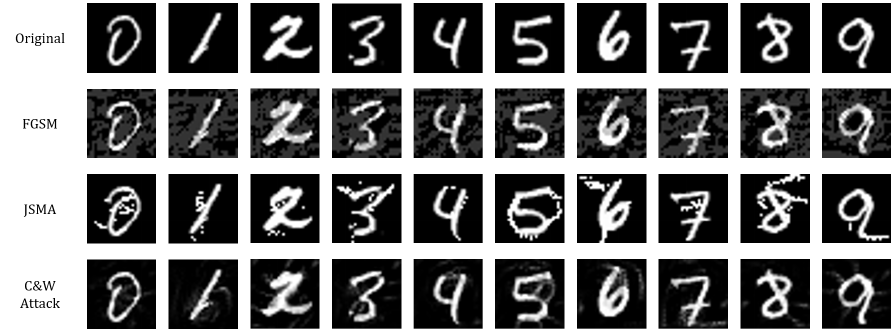
Figure 1. Image of original MNIST and adversarial attacked examples generated by FGSM, JSMA and C&W L 2